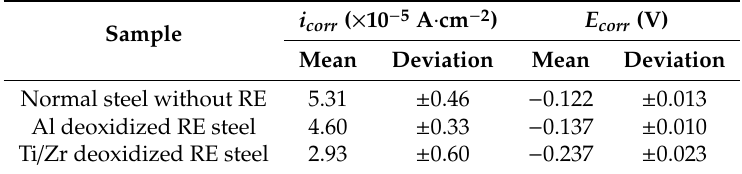
Figure 2. Corrosion weight loss of steels in a 3.5 wt.% NaCl solution. Table 2. Corrosion current density and corrosion potential obtained from potentiodynamic polarization curves in Figure 1.